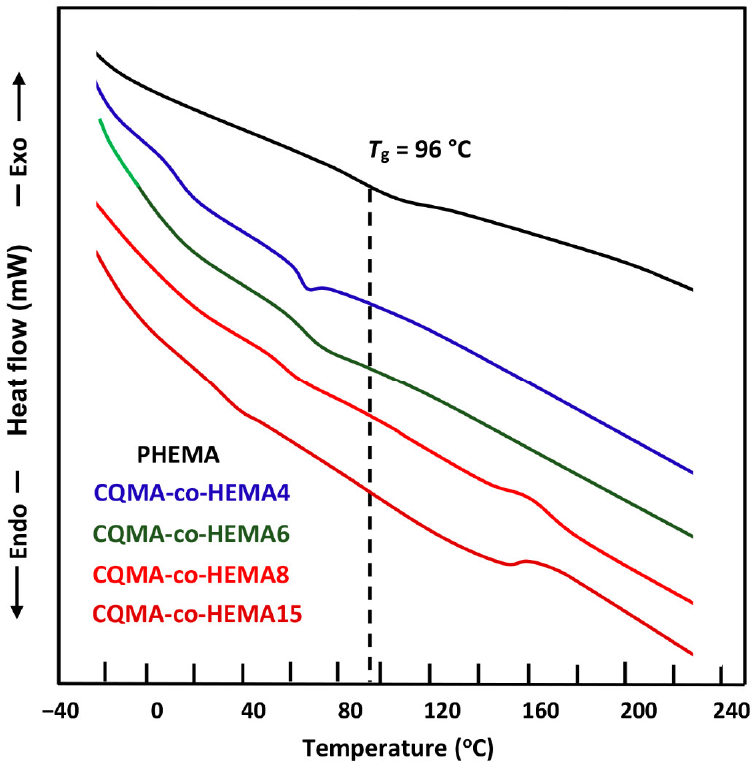
Figure 8. DSC thermograms of PHEMA and CQMA-co-HEMA with different compositions.